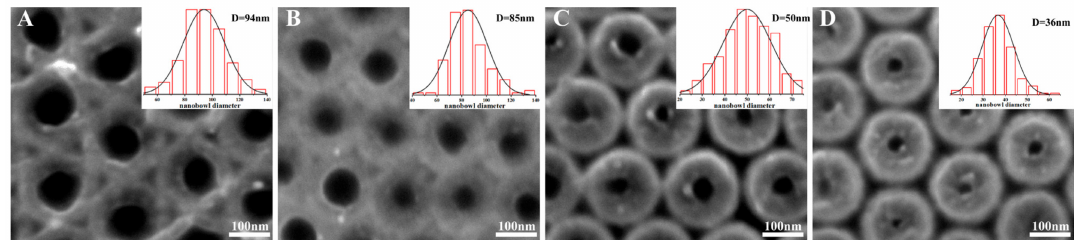
Figure 3. Top-view SEM images of nanomace arrays when transferred to a new Si substrate. The nanoholes with different sizes are observed when the PS templates are etched for ( A ) 0 s; ( B ) 60 s; ( C ) 90 s; ( D ) 120